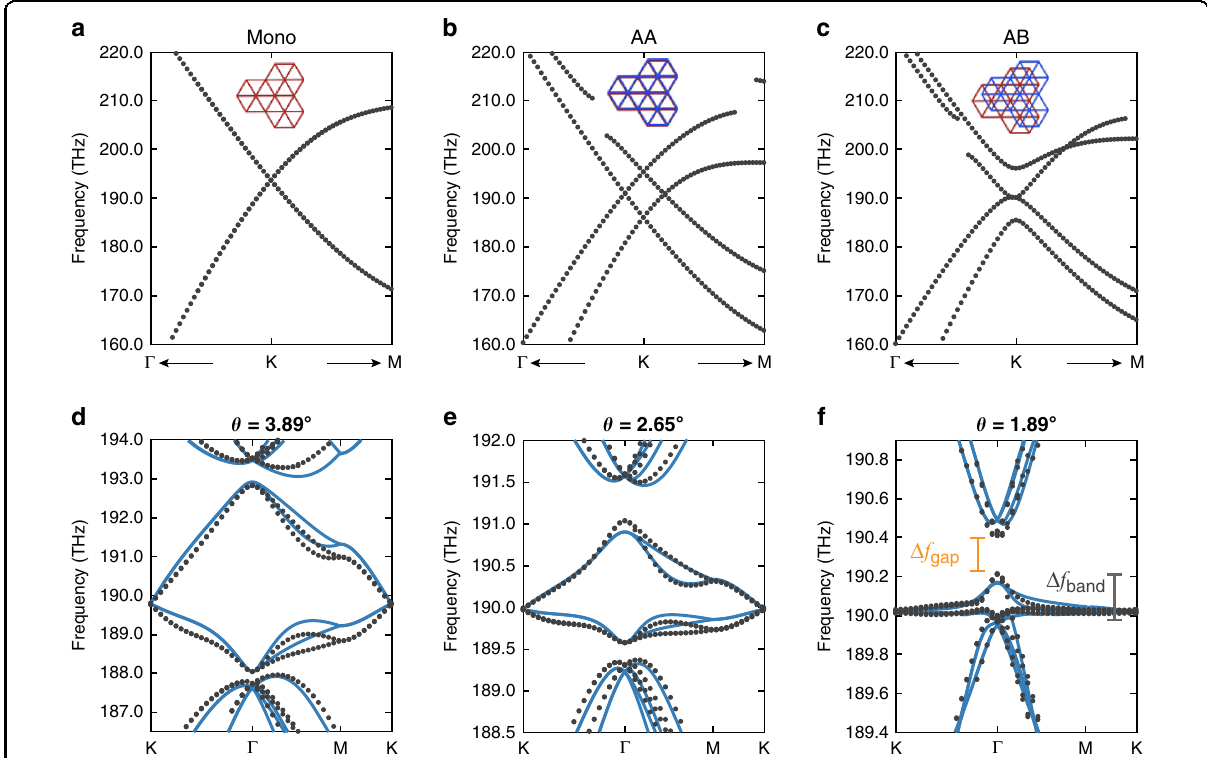
Fig. 2 Band structures. Band structure of the monolayer ( a ), AA-stacked ( b ), and AB-stacked BPhCs ( c ). In b – d , the insets show the respective real- space con fi guration of the crystal unit cells. Band structure obtained from the fi nite-element calculation (black dots) and fi tted continuum model band structure (blue line) of d θ ¼ 3 : 89 (cid:2) , e θ ¼ 2 : 65 (cid:2) , and f θ ¼ 1 : 89 (cid:2) . At small angles, the Dirac cones from each layer are pushed together